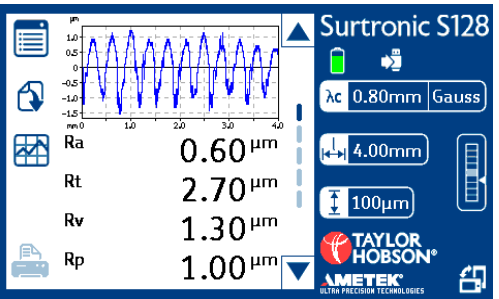
Figure 6. Chart for mode Ra 0.6. Partial evaluation of the average arithmetic deviation of the profile Ra: Table 6. Sample No.1 after • Component No.1 is the extreme negative surface roughness value for three measure- ments and a very good value for measurements for No.4. The condition is caused by